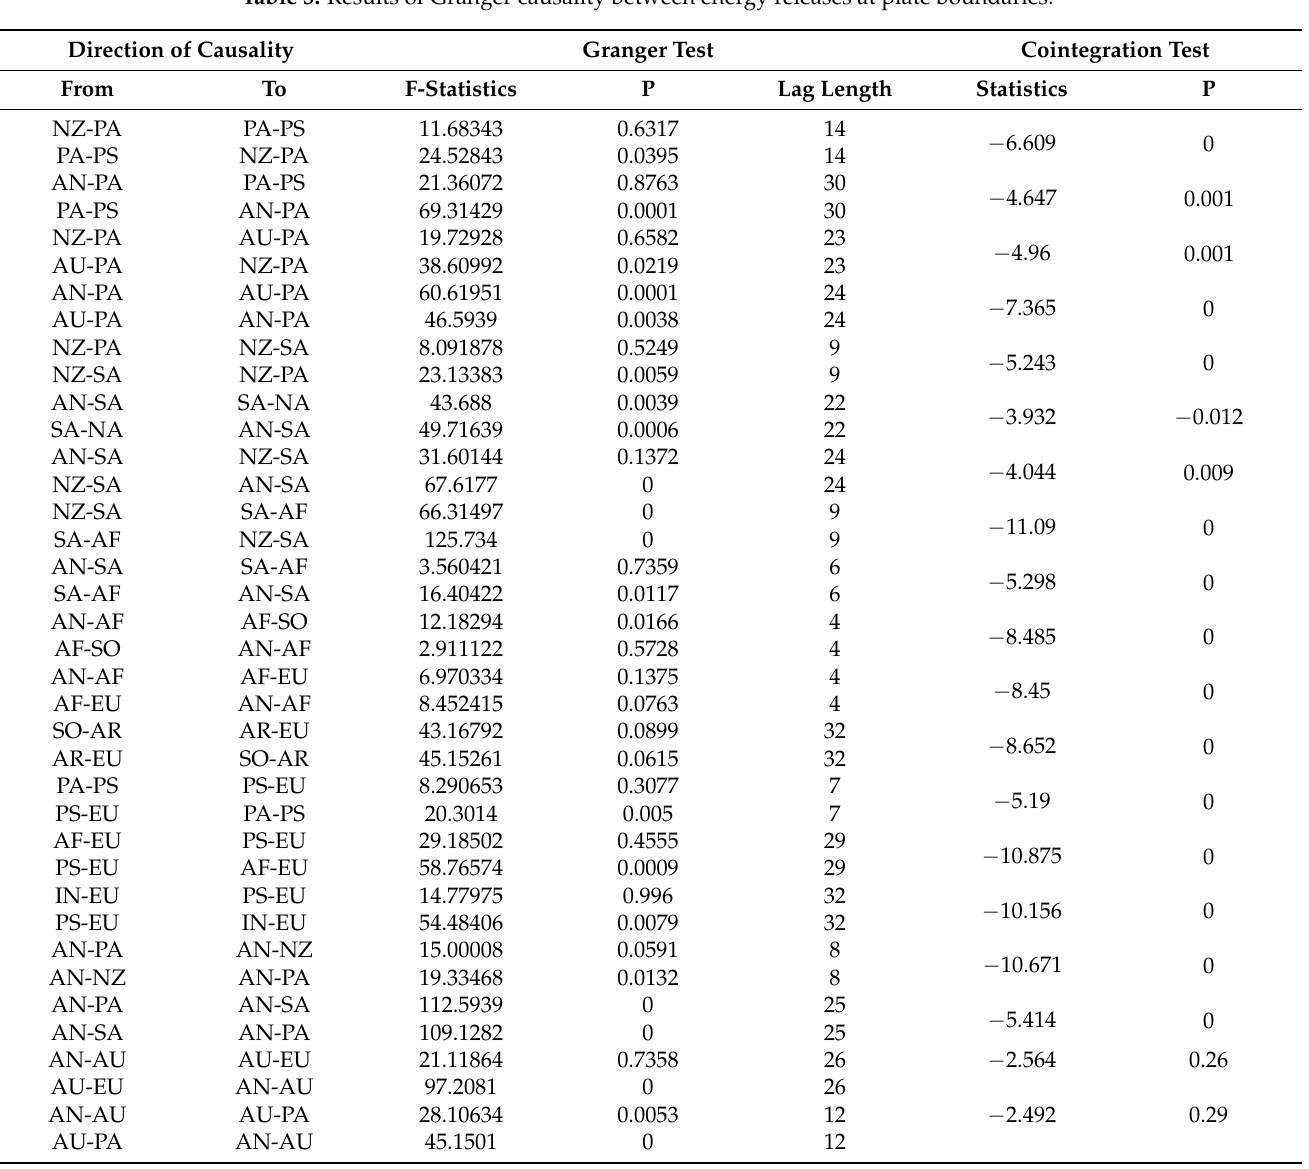
Table 3. Results of Granger causality between energy releases at plate